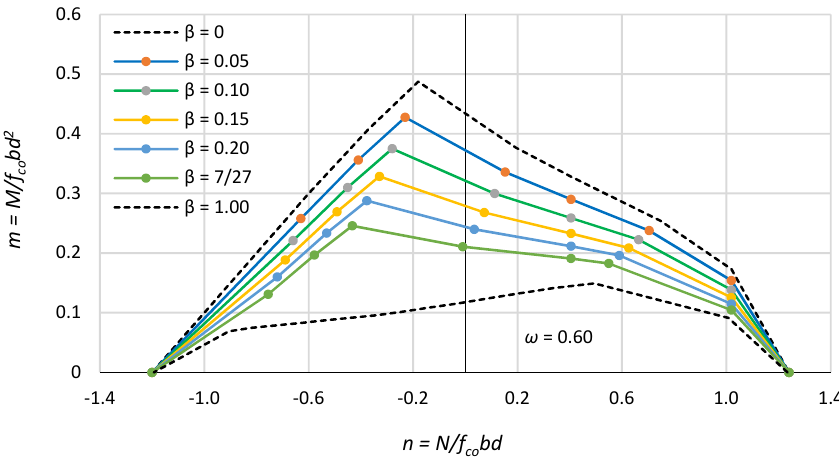
Figure 5. Effect of the location of the bars β in the section on the interaction n–m.